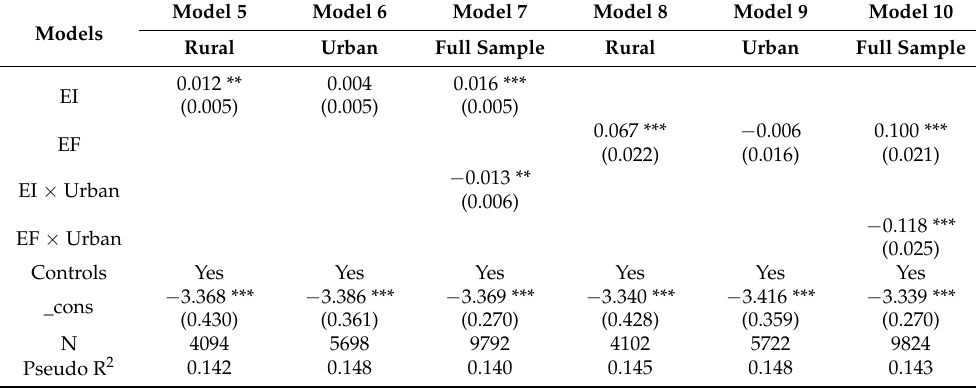
Table 3. Comparison of urban/rural residents.